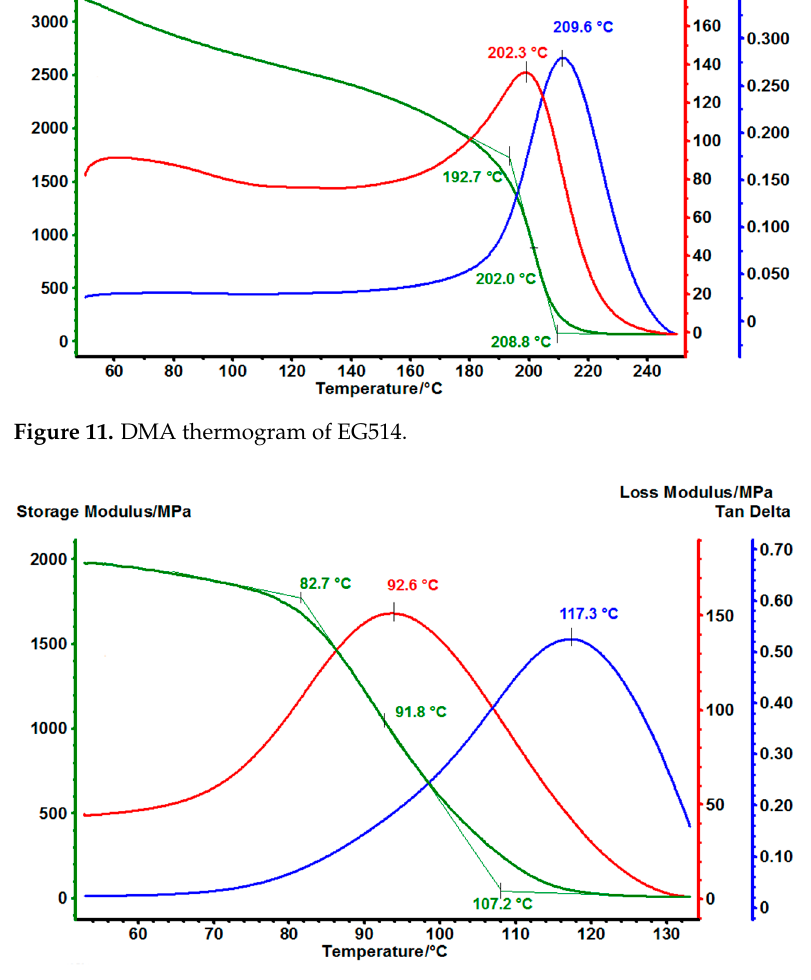
Figure 12. DMA thermogram of EG531.